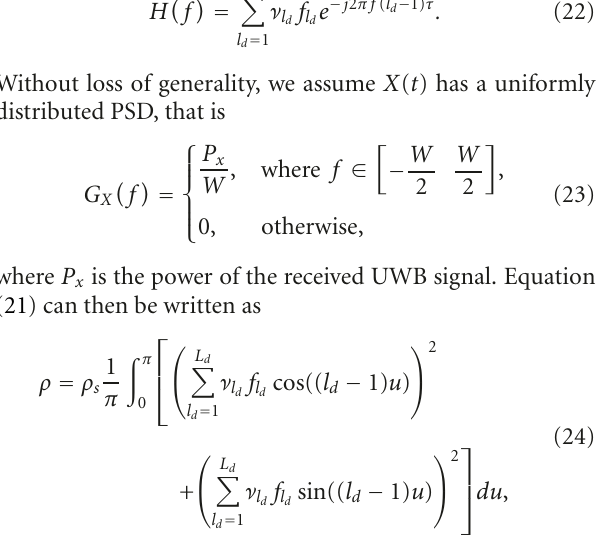
Figure 1: Frame error rate for PPM and DPPM over an AWGN channel with a frame length of 128bits.